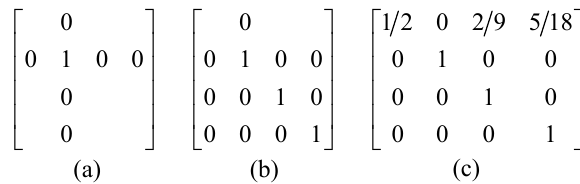
= 2/9. Finally, the transfer matrix of this coarse pixel is generated.